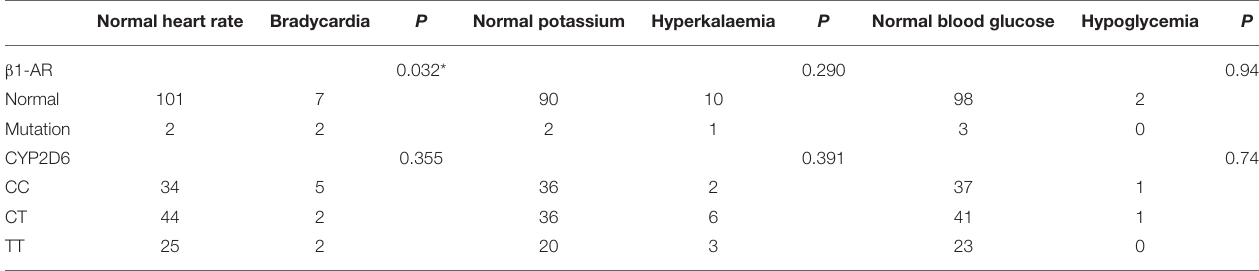
TABLE 3 | β 1-AR, CYP2D6 gene mutation and adverse